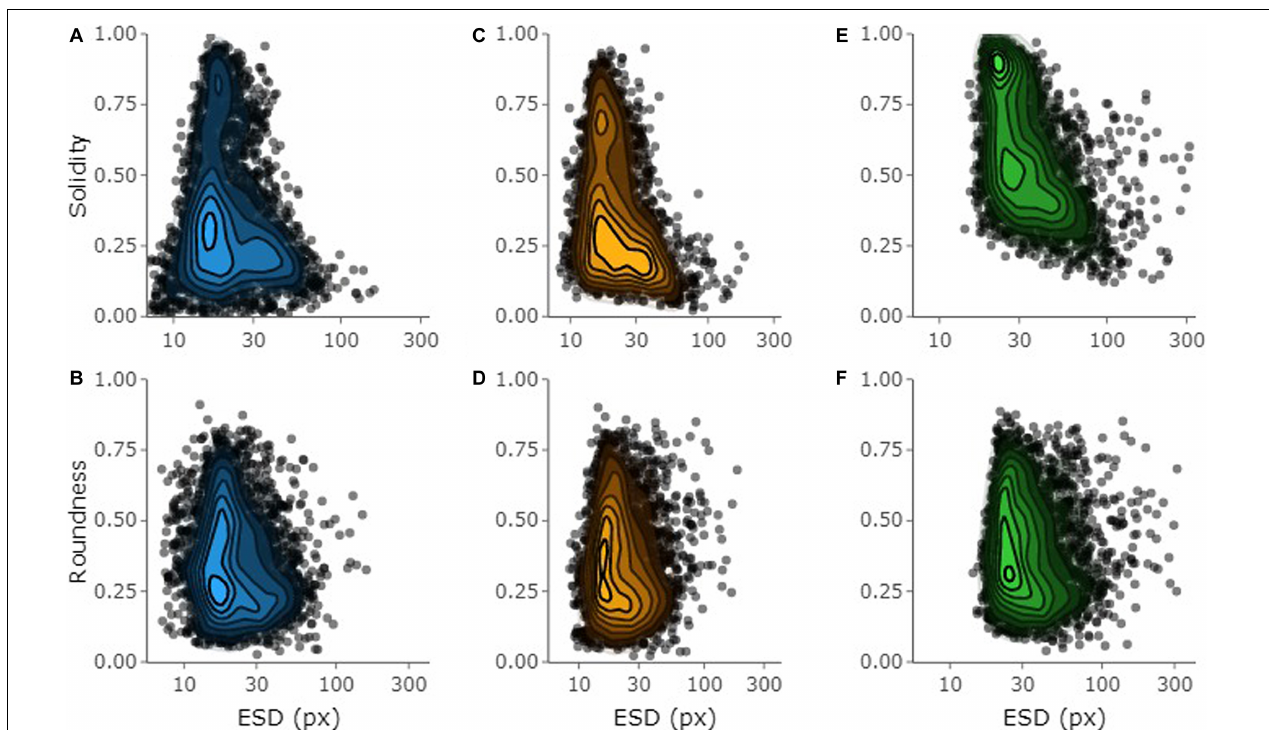
FIGURE 9 | Heat map of (A–C) solidity and (D–F) roundness of particles as a function of size (ESD in pixels) for profile DY086-034 near South Georgia. The closer the values are to 1, the more solid and circle-like the particles are. Note the logarithmic scale for the x-axis. Values based on (A,B) Yen (blue), (C,D) Otsu (orange), and (E,F) Sobel (green) thresholding. Lighter colors indicate higher density of data points. Pixel size: 4.4 µ